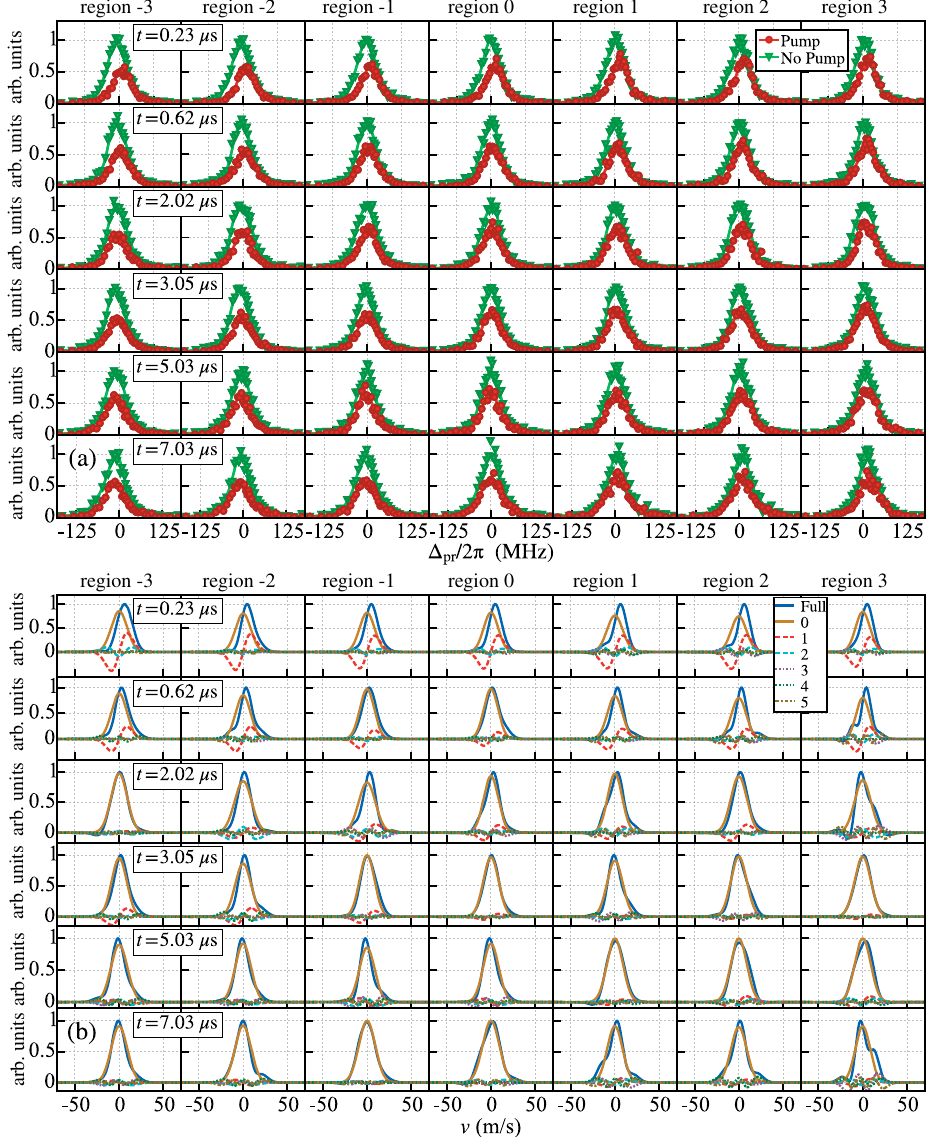
FIG. 7. (a) Pumped and unpumped LIF spectra from regions of width 0 . 1 σ x across the plasma cloud spanning x ¼ (cid:4) 0 . 2 σ x for the plasma described in Fig. 6. (b) Pumped and unpumped velocity distributions determined from the spectra shown in